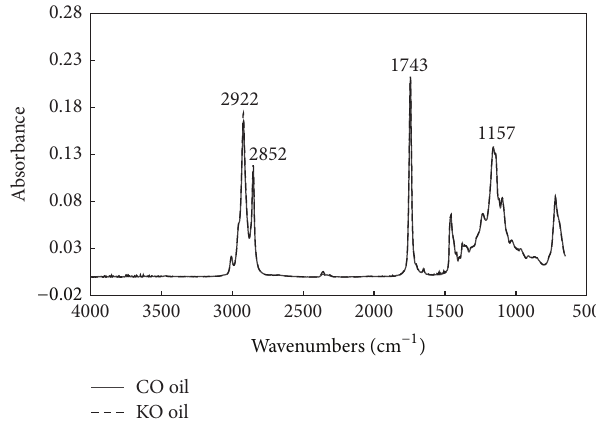
Figure 1: FTIR spectra of canola (CO) and Kizakinonatane (KO) frying oil samples.